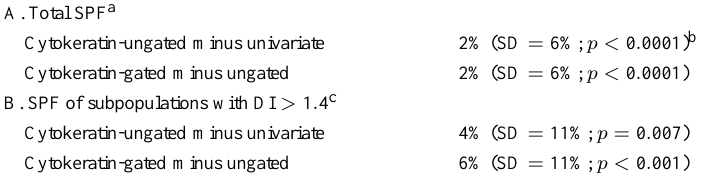
Estimates of the mean difference of the adjusted SPF between univariate and bivariate DNA